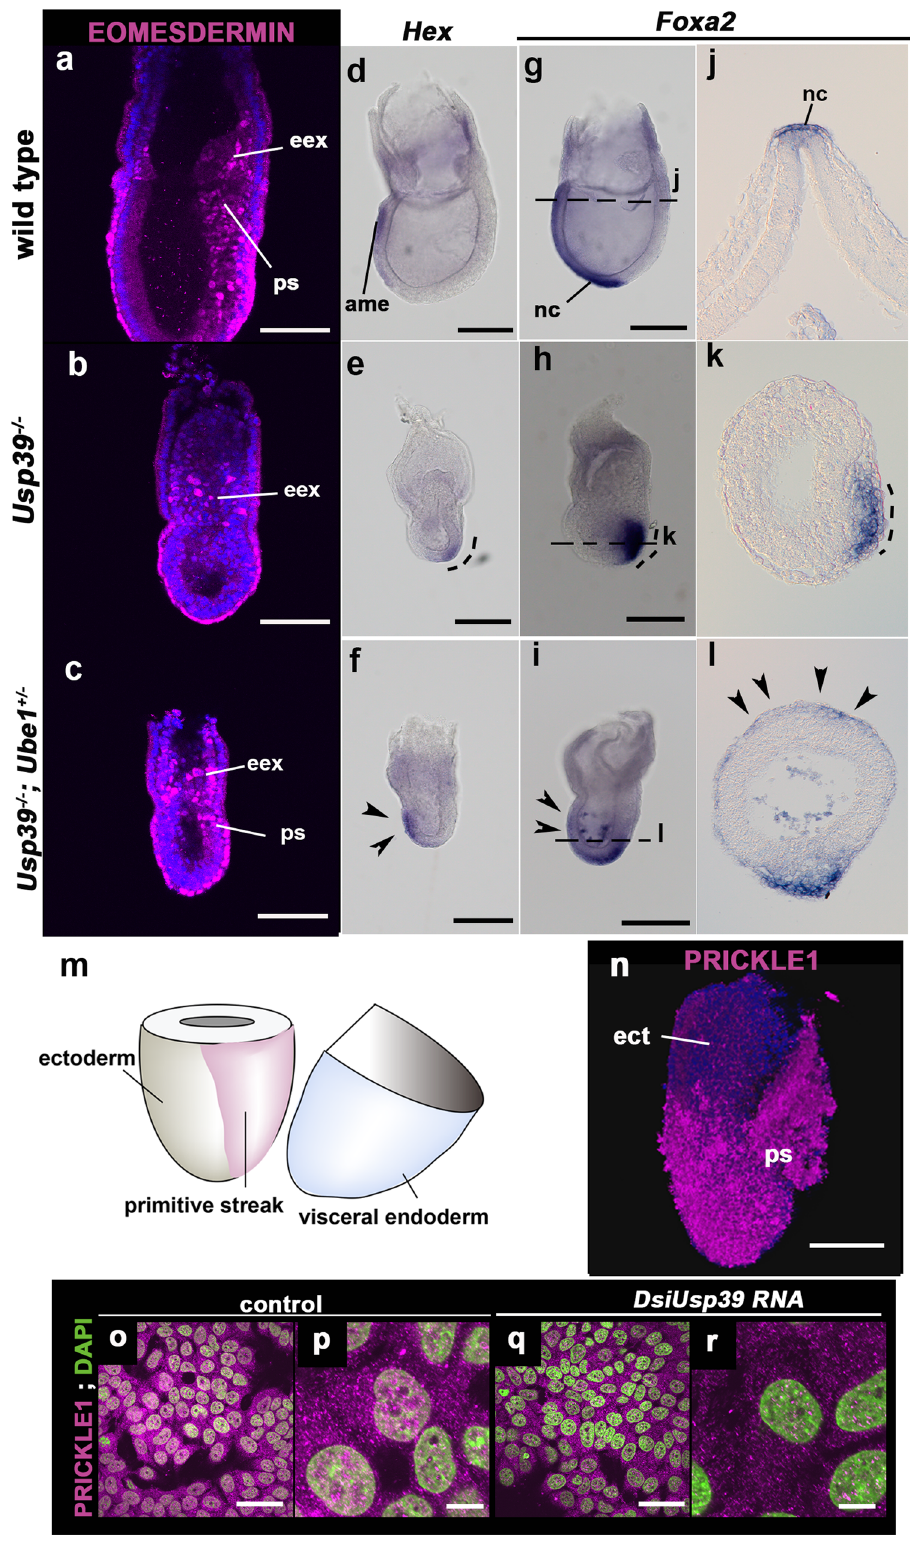
the cytoplasmic function of GRHL3, which is mediated by a non- canonical Wnt signaling pathway rather than β -catenin -depen- dent canonical Wnt pathway. USP39 is necessary to non-canonical Wnt-dependent processes through the correct expression of PCP components during mouse epithelial morphogenesis (Figs. 4 – 8, 10a, and S13).